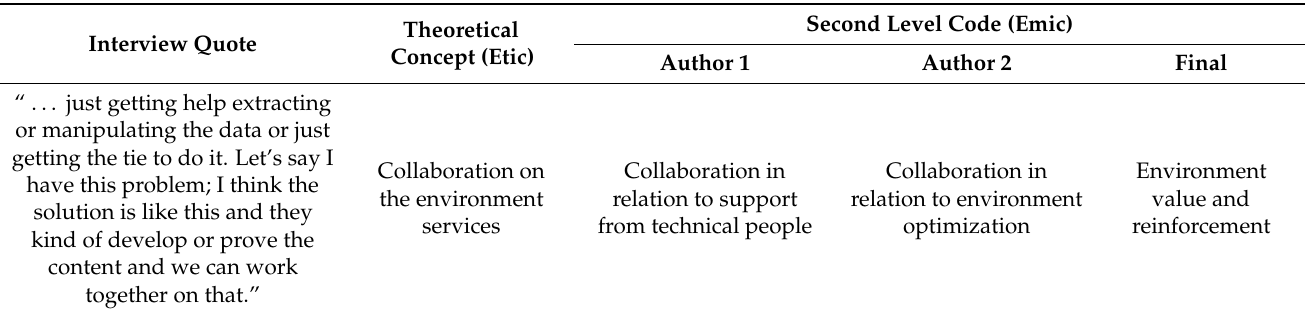
Table 1. Data analysis